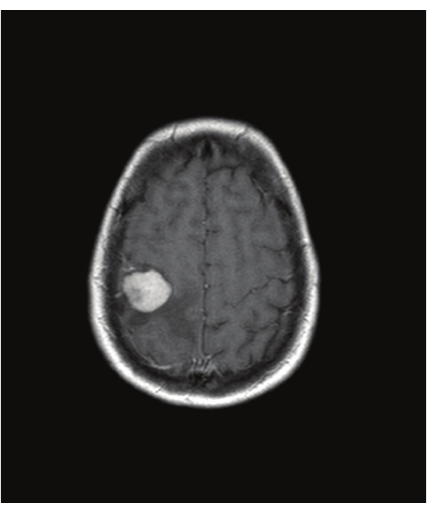
Figure 1: Preoperative MRI showing the mass in the right frontal lobe.